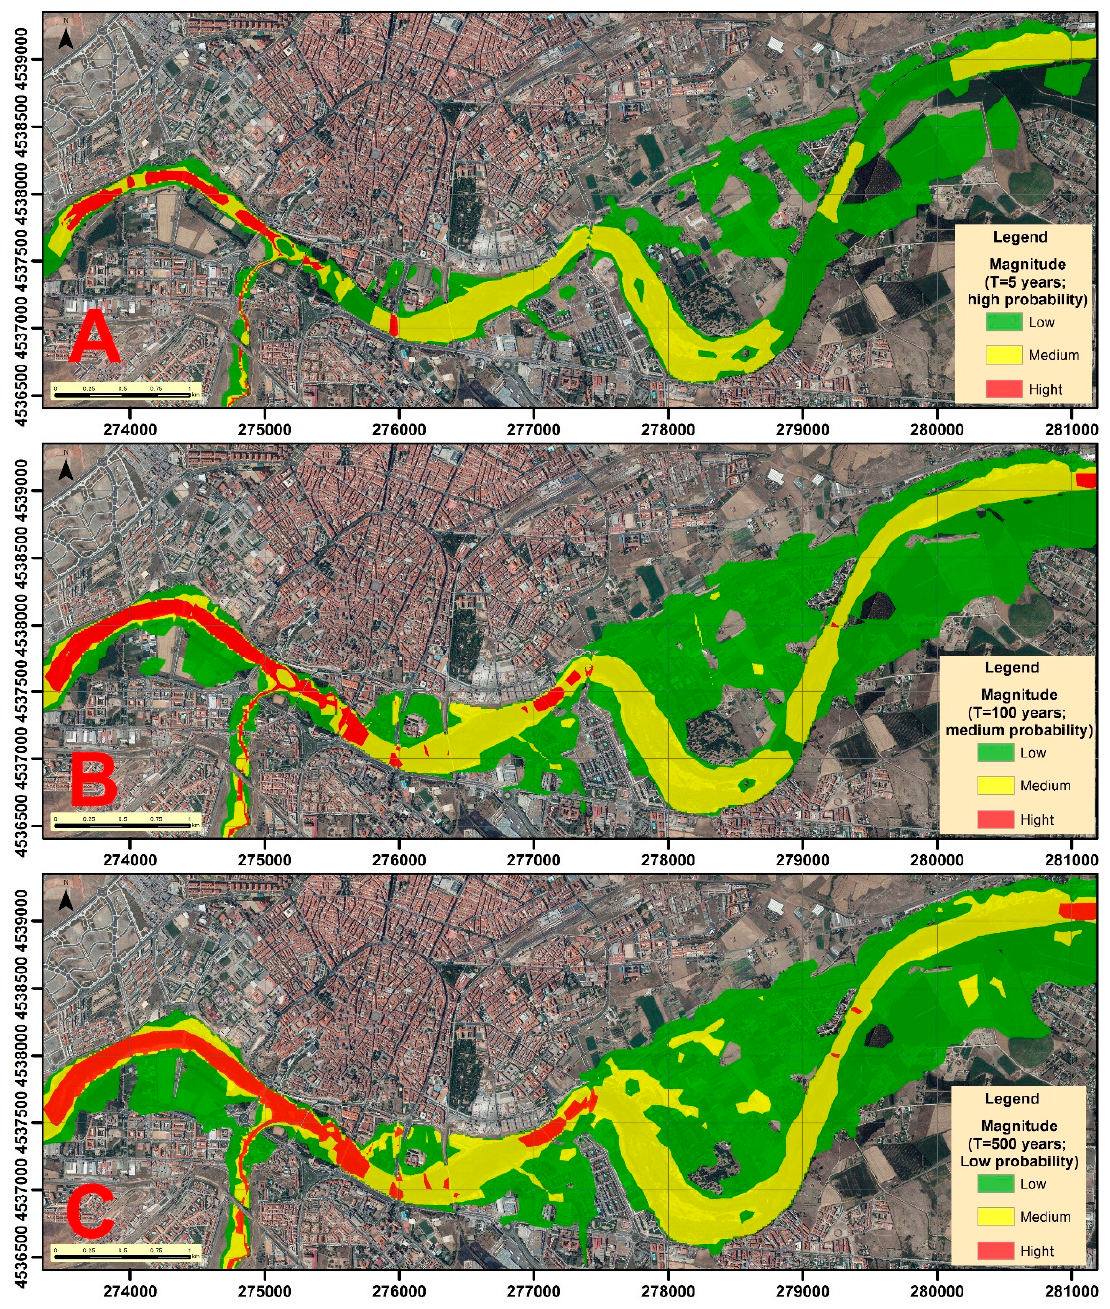
Figure 4. Flood probability of the areas surrounding the river.